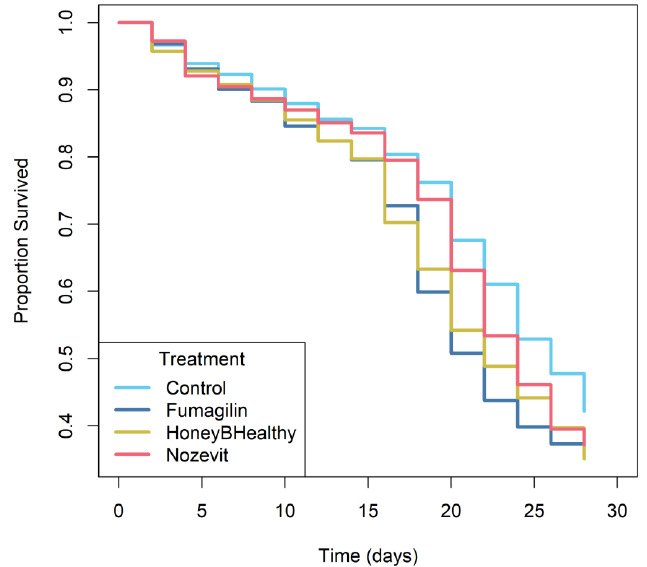
Figure 1. Proportion of honey bees that survived Vairimorpha ceranae infection and subsequent treat-